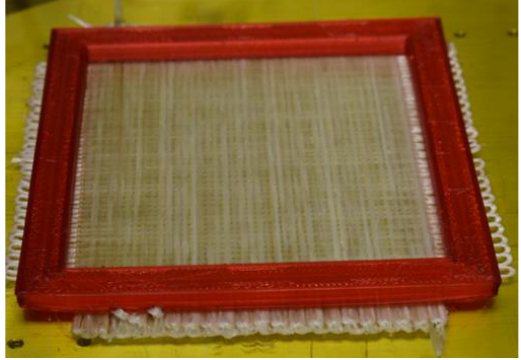
Figure 7. Outer Edge Closure 3D Printed on the Lower Fiber Reinforced Facesheet.